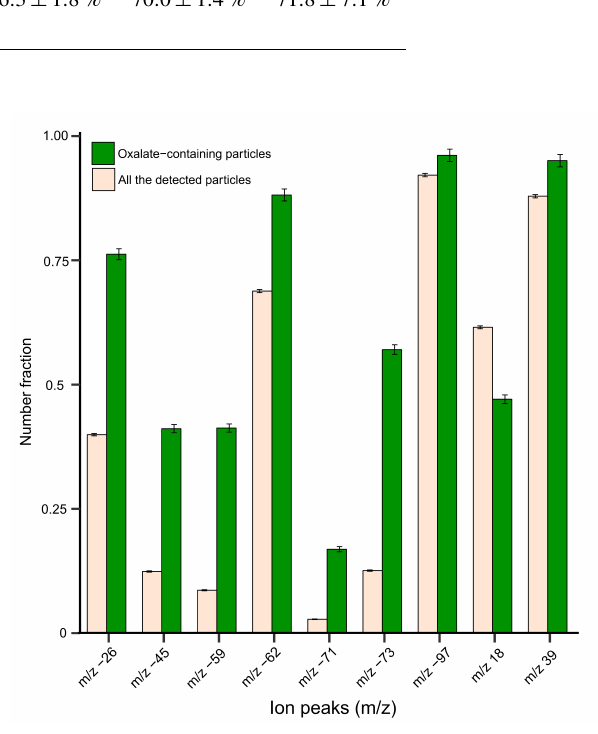
Figure 3. Number fractions of the major ion peaks in oxalate- containing and all the detected